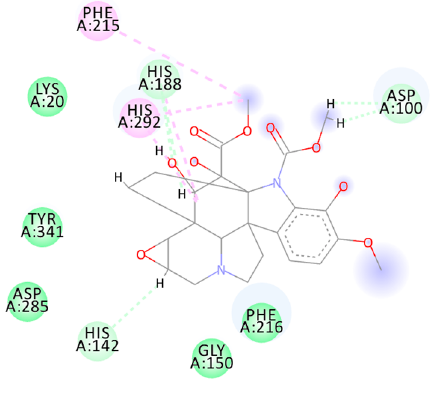
Figure A3. Molecular docking interactions between the five selected VS hits and the 1VYF protein. The light green represents the van der Waals interactions, the green represents the conventional H-bonds, and the pink represents the pi-interactions.